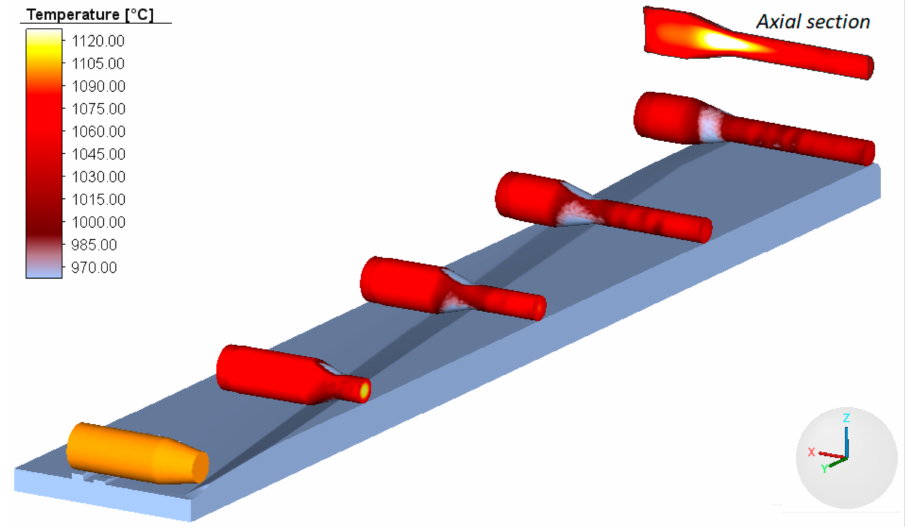
Figure 9. Successive stages of the CWR test conducted with the billet preheated to 1100 ◦ C, with images showing the distribution of temperature.